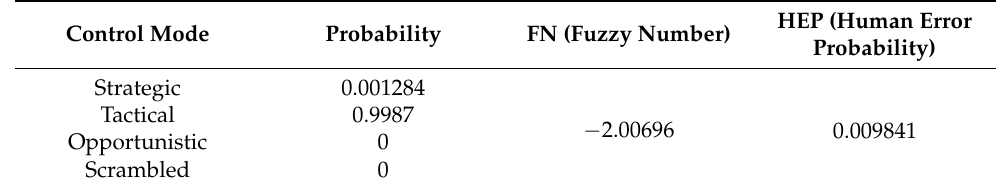
Figure 9. The probabilities of the COCOM node’s states.